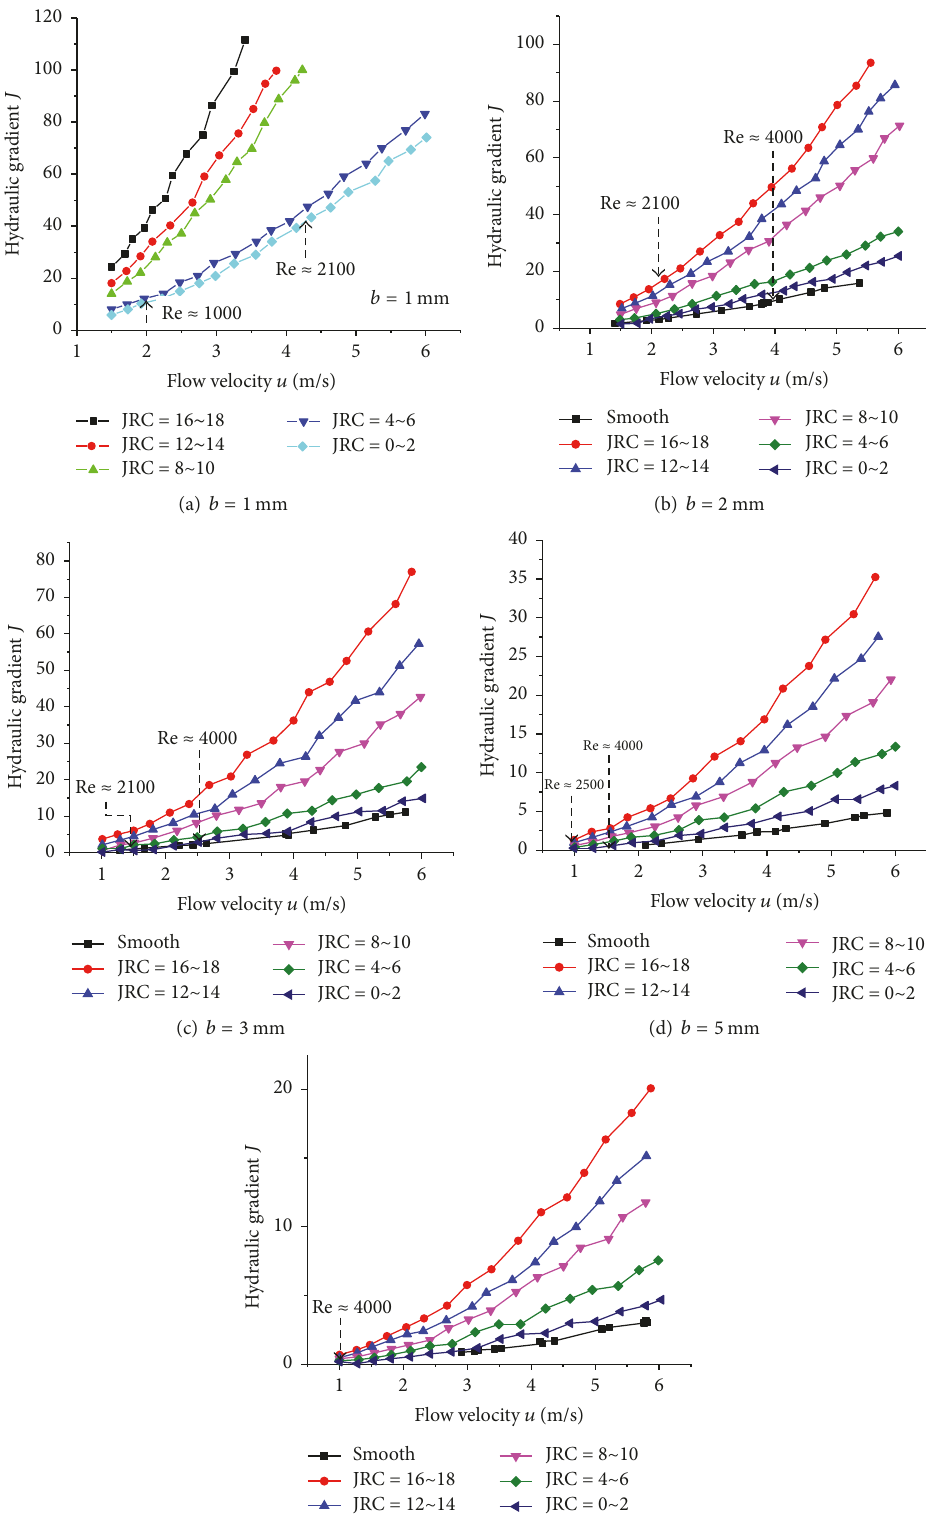
Figure 8: Relationship between hydraulic gradient and flow velocity at different JRC and